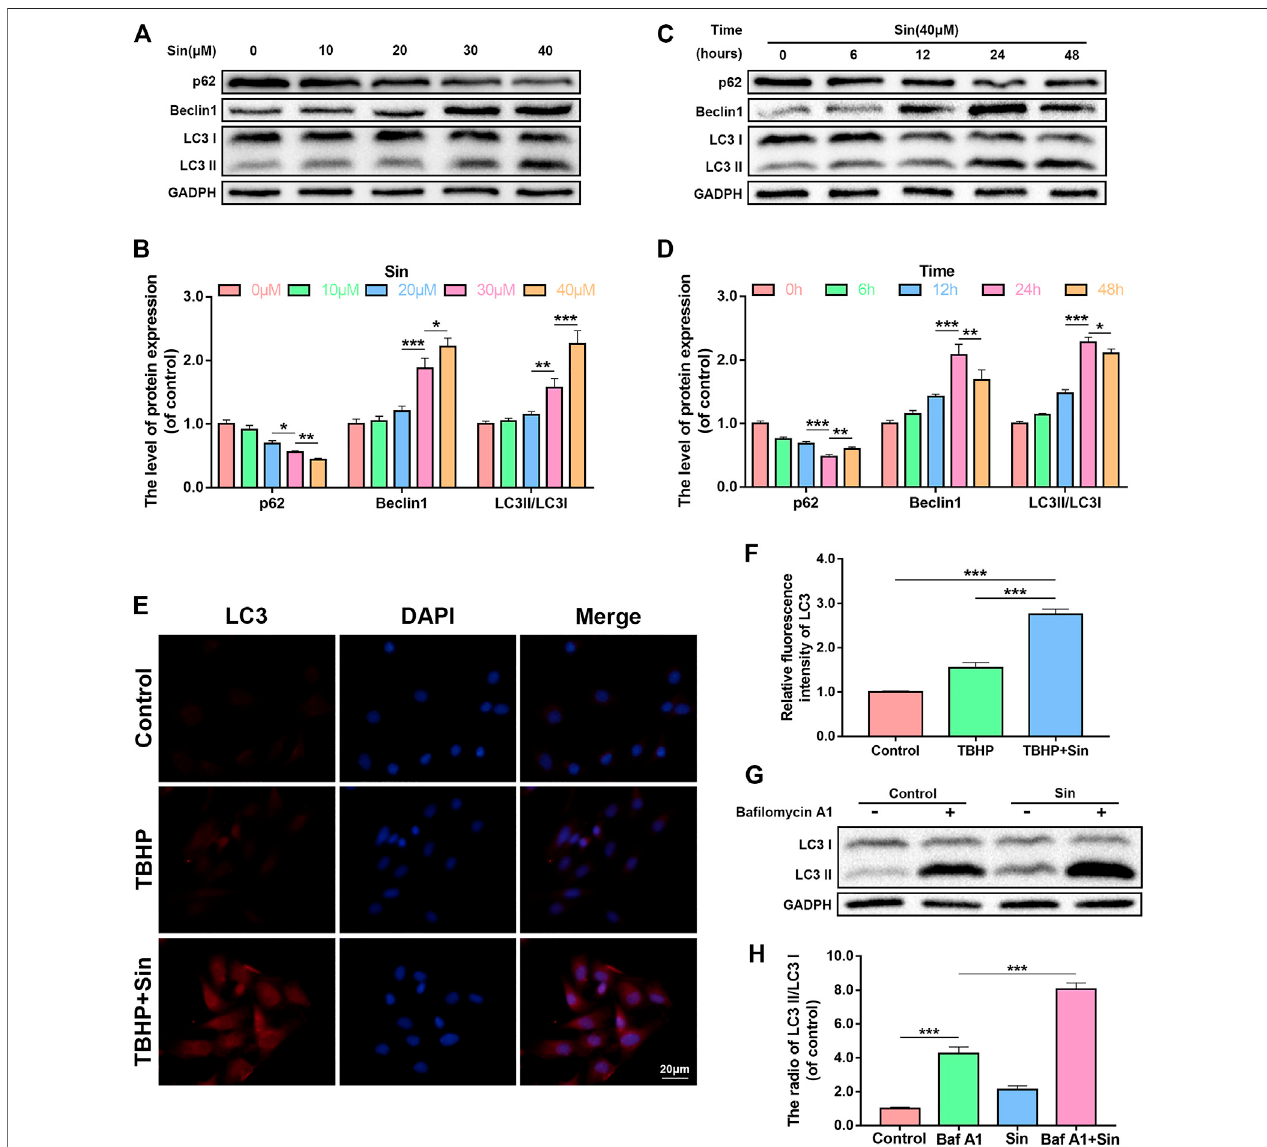
FIGURE 4 | Sin activates autophagy in chondrocytes. (A, B) The results of dose-dependent western blotting show that the levels of p62, Beclin1, and LC3II/LC3I ratioinchondrocytes treatedwithdifferentconcentrationsofSin(0,10,20,30,and40 μ M)for24 h. (C,D) Theresultsoftime-dependent westernblottingshowthatthe levels of p62, Beclin1, and LC3II/LC3I ratio in chondrocytes treated with 40 μ M Sin for different times (0, 6, 12, 24,and 48 h). (E, F) The results of immuno fl uorescence show the intensity of LC3 in the chondrocytes treated with or without 40 μ M Sin for 24 h and 30 μ M TBHP for 24 h (Scale bar: 20 μ m). (G, H) The western blotting resultsshowthatthelevelsofLC3II/LC3Iratioinchondrocytes thatwerenottreated,ortreatedwith100 nMba fi lomycinA1for1 h,ortreatedwith40 μ MSinfor24 h,or treated with ba fi lomycin A1 and Sin. The data are presented as the means ± SD ( n (cid:1) 3); * p < 0.05, ** p < 0.01, and *** p < 0.001.